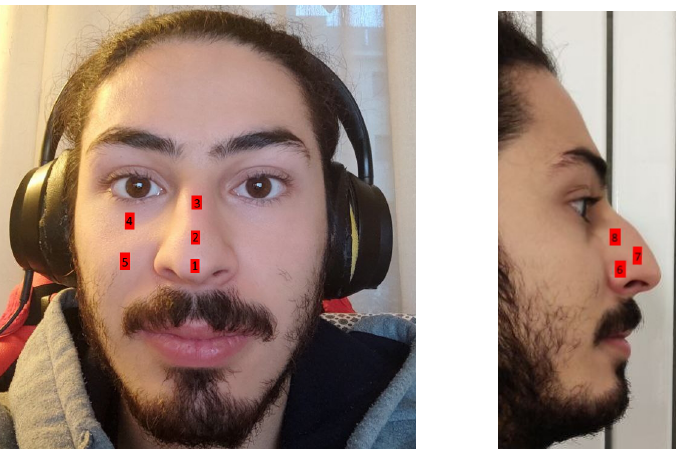
Figure 7. Tests of MAX30102 sensor to find the best point on the face to capture SpO 2 and HR. Experiments have been conducted to validate the position. The data points collected were compared with those of the Beurer PO 30 pulse oximeter, placed on the finger, which are taken as ground-truth data. In particular, the latter has an accepted measurements error of ± 2% for both pulse rate ( ± 2 bpm) and SpO 2 (70–100%). The results are shown in Table 2. It can be seen that data gathered from point 7, on the nose, perform better and can be adjusted accordingly to achieve reliability of such health information. Table 2. The table shows the absolute error from the ground-truth for each face point of both SpO 2 (in perentage points) and HR (in